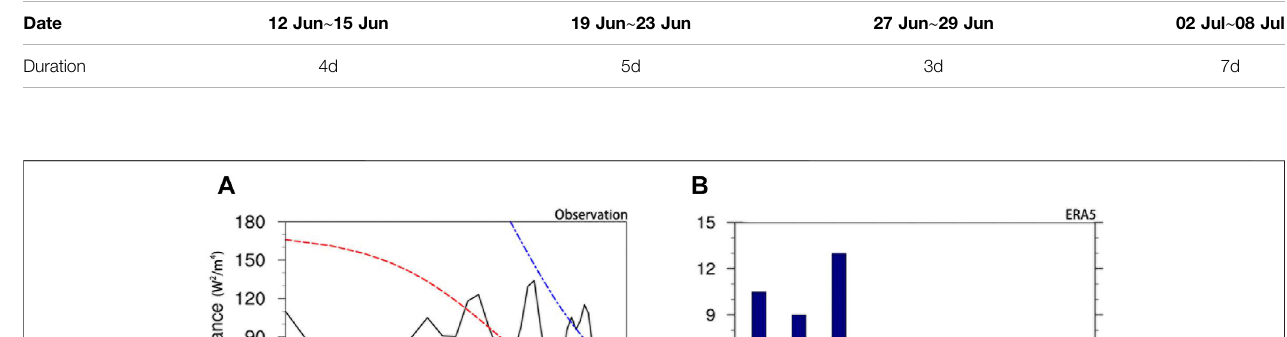
TABLE 2 | Duration of 2020 PHREs in Meiyu period.